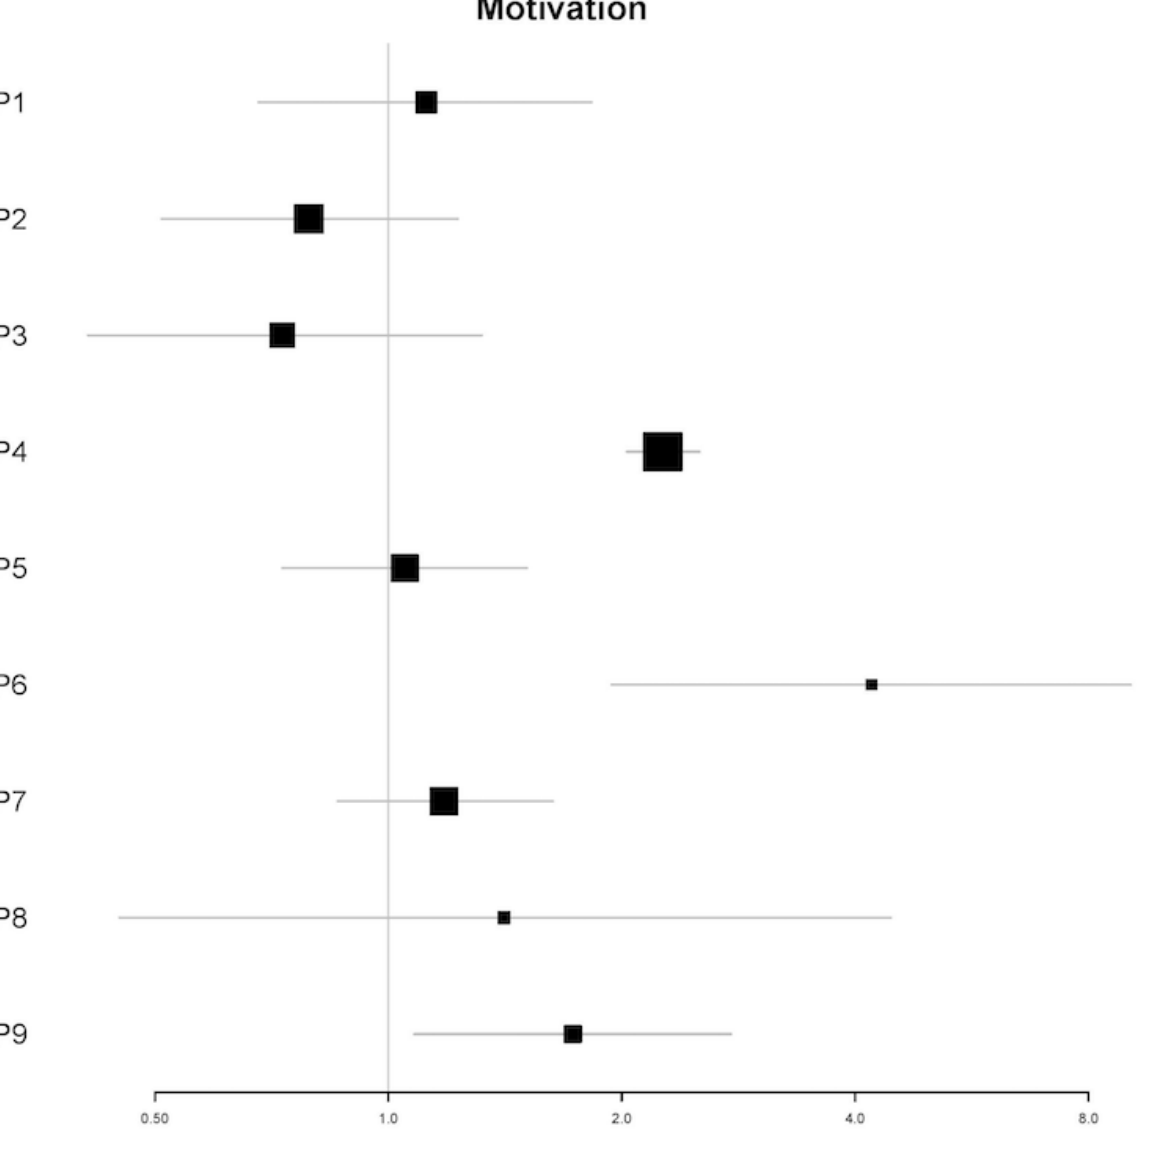
Figure 4. Plot of incidence rate ratios and 95% CIs (x-axis) for the association of motivation to reduce alcohol and the amount of engagement for each participant (y-axis) in univariable analyses. P: